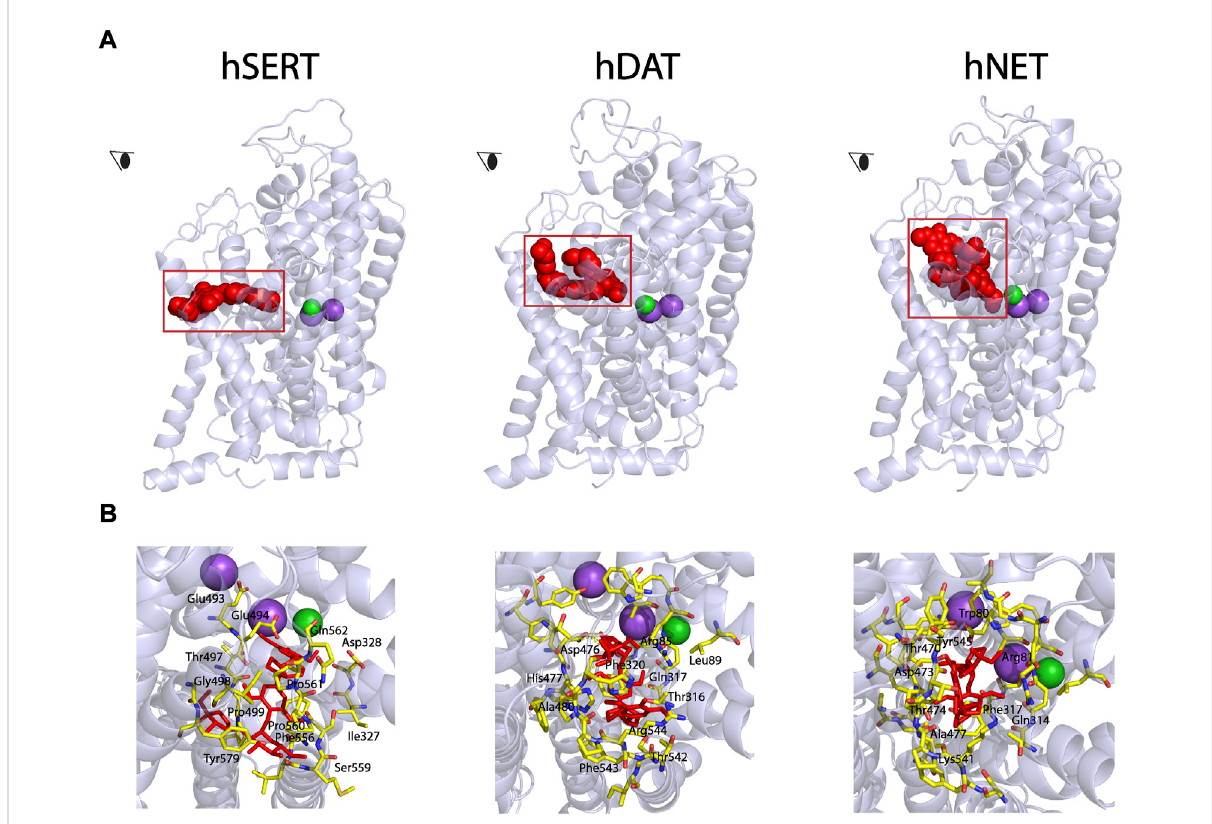
FIGURE 2 Molecular dockingofSAGtotheallostericsiteinhSERT,hDAT,andhNET. (A) OverallviewsofhSERT-SAG( left ),hDAT-SAG( middle ),andhNET- SAG( right )complexesincartoonrepresentation.SAG( red )intheallostericbindingsitewasdepictedasspheres.Purpleandgreenspheresrepresents Na + and Cl − ions, respectively. The eye represents the angle views depicted in (B) . (B) Close-ups of SAG binding in the allosteric site. Residues that interact with SAG are annotated and shown in yellow sticks